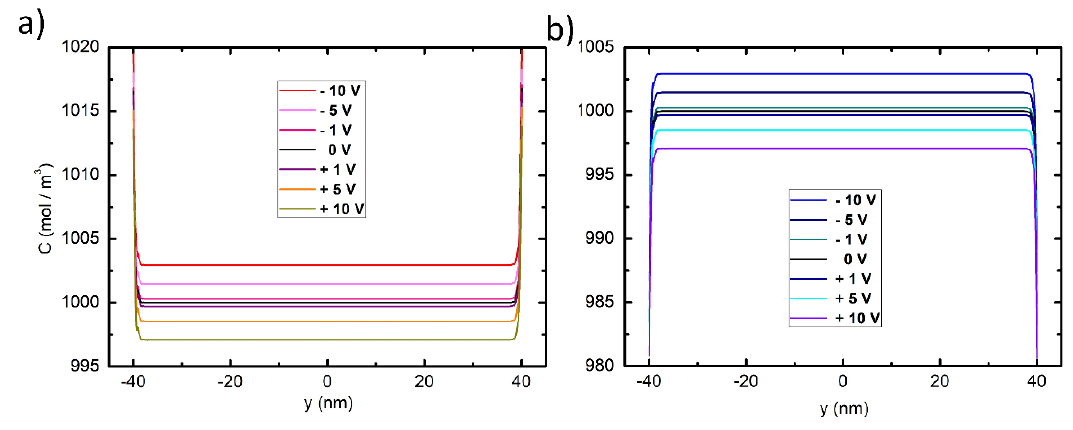
Figure 3. K + ( a ) and Cl − ( b ) ion concentration along the transversal section at the middle of the nanochannel as a function of the applied voltage between the reservoirs (C Bulk = 1 M = 10 3 mol/m 3 ).